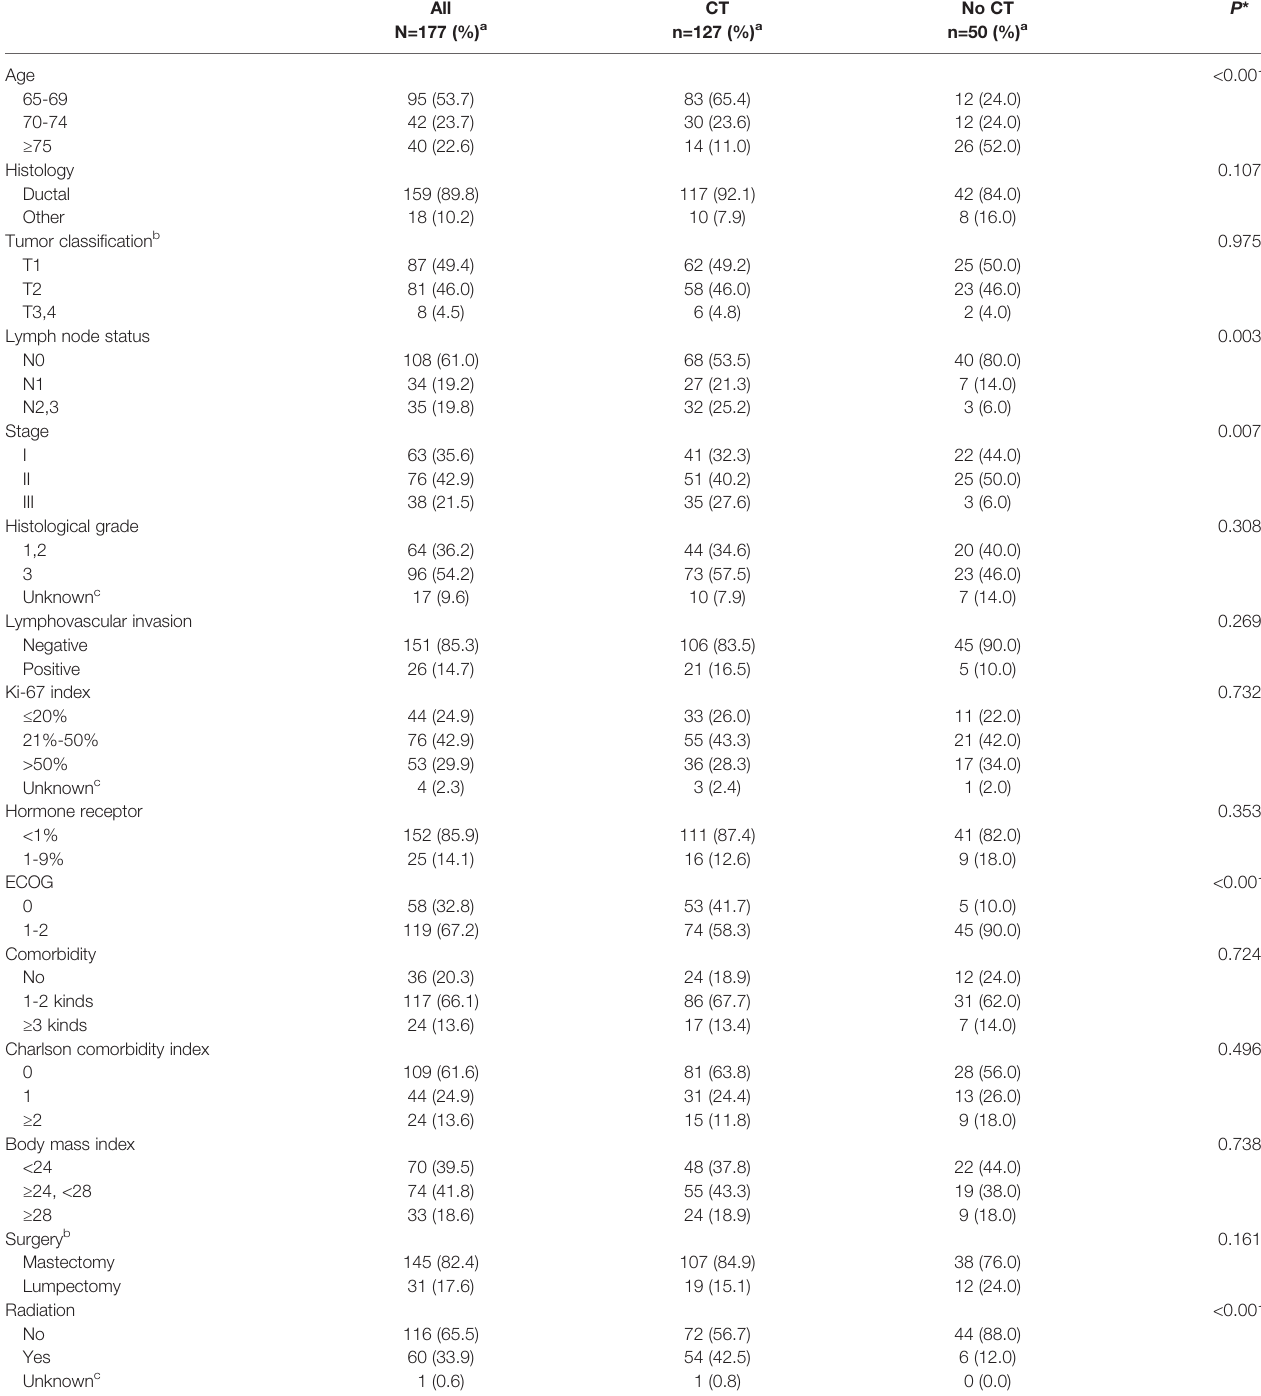
TABLE 1 | Characteristics of